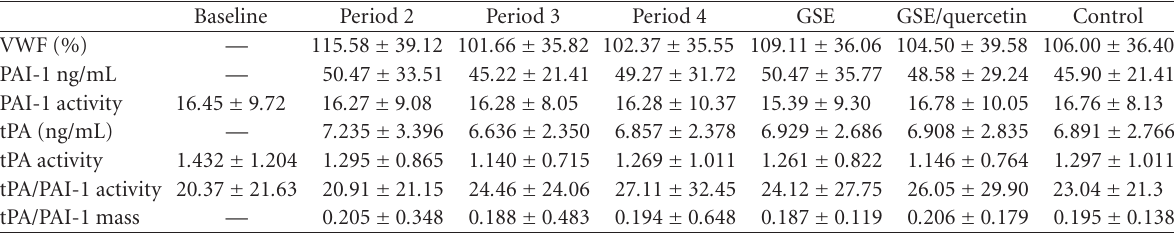
Table 5. E ff ect of GSE and GSE/quercetin on clotting and fibrinolytic factors. N = 35, mean SD. Baseline Period 2 Period 3 Period 4 GSE GSE/quercetin